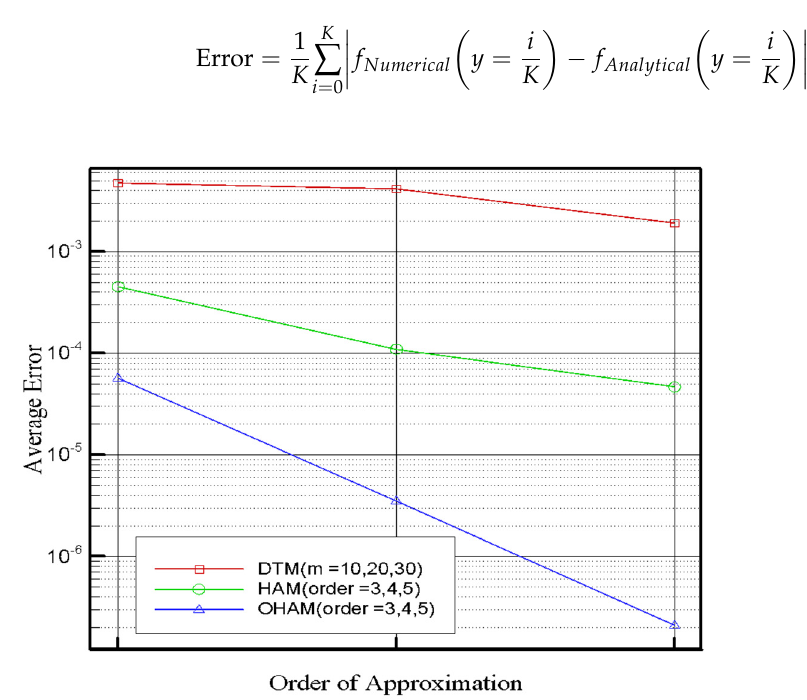
Figure 5. Comparison of average error of different approaches at different orders of approximation for the case of Re = 5 and α = 1.